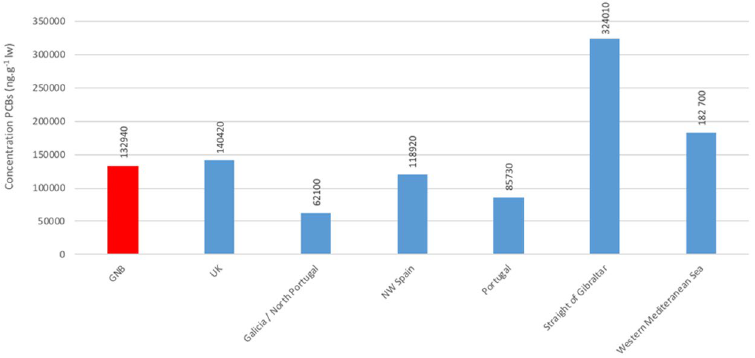
Figure 5. Mean PCB concentrations in male bottlenose dolphins from the Normanno-Breton Gulf (NBG, red bar, present study, Σ 6 NDL-PCBs) compared to the Σ PCBs from other European locations 4